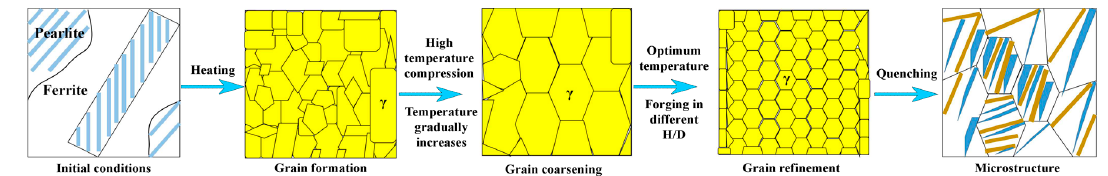
Figure 9. Microstructure evolution mechanism of medium carbon 0.4C-Si-Mn-Cr steel during the process of compression-forging-heat treatment.